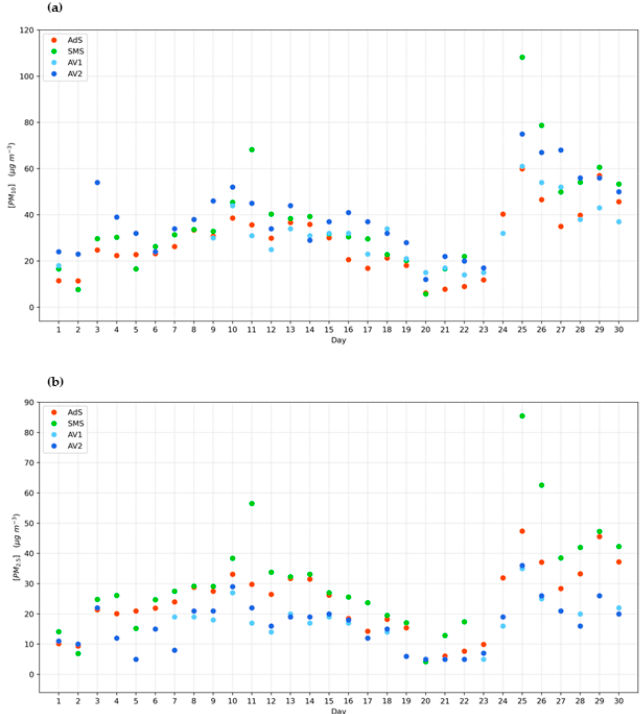
Figure 4. Daily average concentrations of PM 10 ( a ) and PM 2.5 ( b ) during September 2021 at AV1, AV2 and AURA (AdS; SMS) monitoring stations. T able 3. Pearson correlations of PM 2.5 and PM 10 , for AV1, AV2 and two AURA monitoring stations (Aiello del Sabato and San Michele di Serino) during September 2021 ( p < 0.005). [PM 10 ] AV1